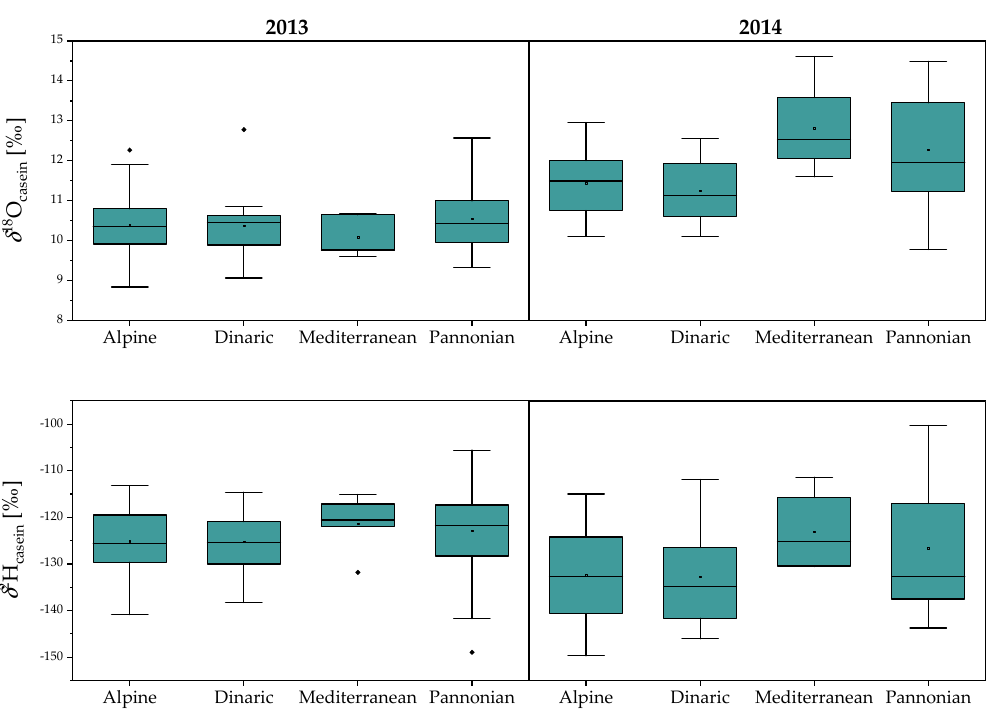
Figure 2. Box plots of δ 2 H casein and δ 18 O casein values in cow milk collected from four macro-regions in Slovenia in 2013 and 2014.